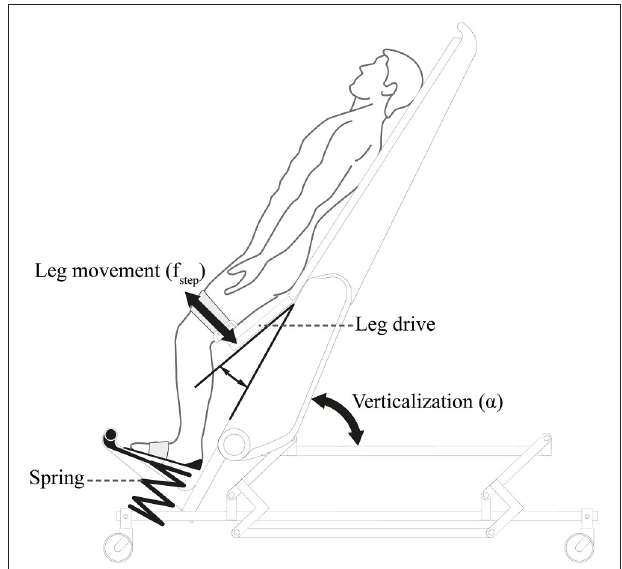
FIGURE 1 | The robot-assisted tilt table Erigo ® : Erigo ® combines verticalization and cyclic passive robotic leg movements [i.e., leg exercise (PE)] to enhance blood circulation and potentially to prevent orthostatic hypotension. Picture is copyrighted by Hocoma AG Switzerland and is adapted with